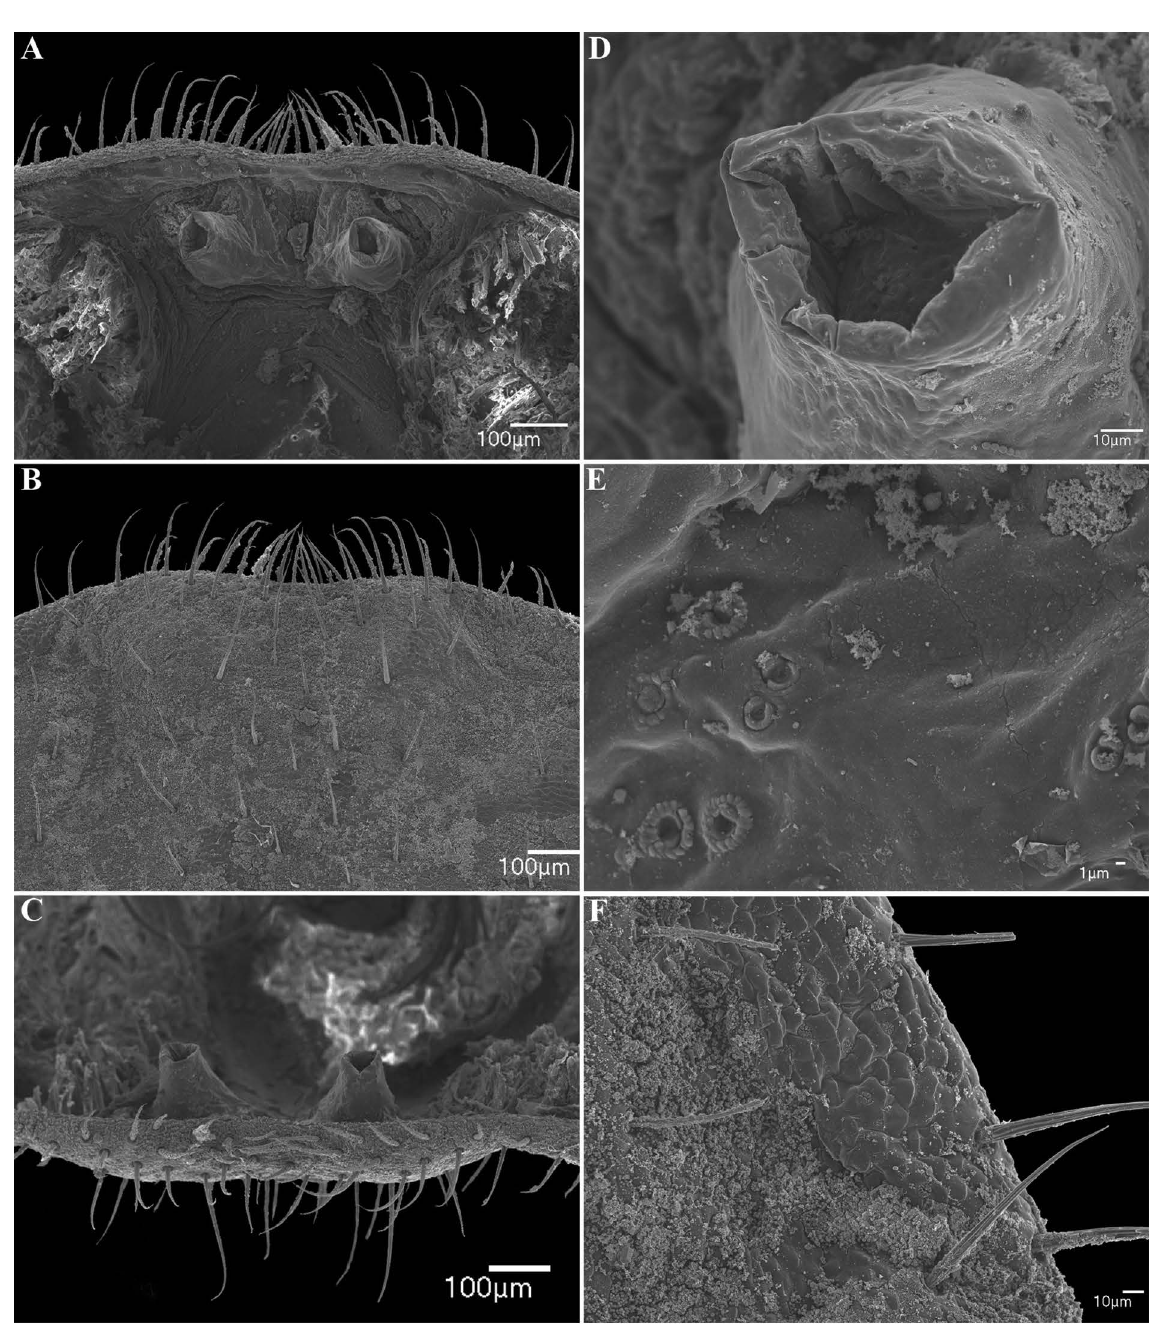
Fig. 67. Charinus imperialis sp. nov. (MNRJ 9032), female gonopod and genital operculum. A . Sucker- like gonopod, dorsal view. B . Posterior margin of genital operculum, ventral view. C . Gonopods, posterior view. D . Dextral sucker-like projection. E . Glandular openings at base of gonopods. F . Slit sensilla on lateral margin of